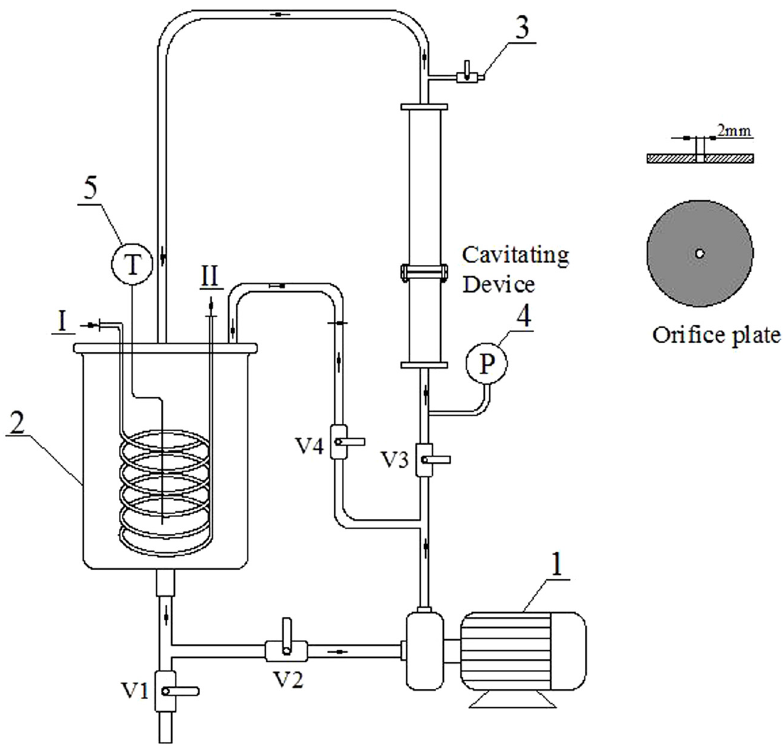
Figure 1: Schematic representation of cavitation device system; ( 1 ) pum, ( 2 ) tank, ( 3 ) sampling valve, ( 4 ) pressure gauge, ( 5 )